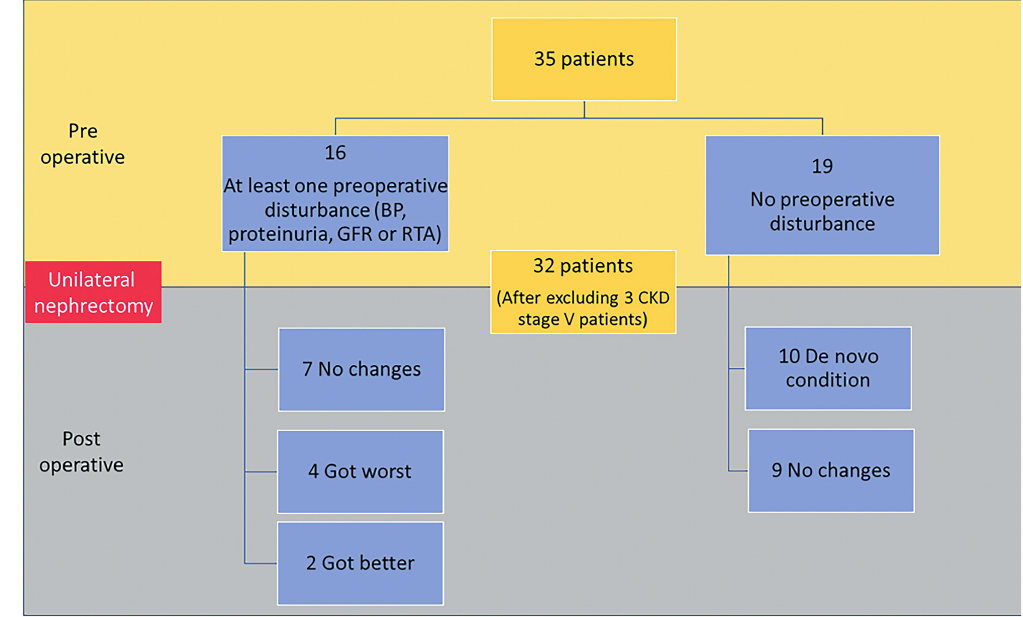
Figure 1 - Overall of pre-surgical and post-surgical patient`s